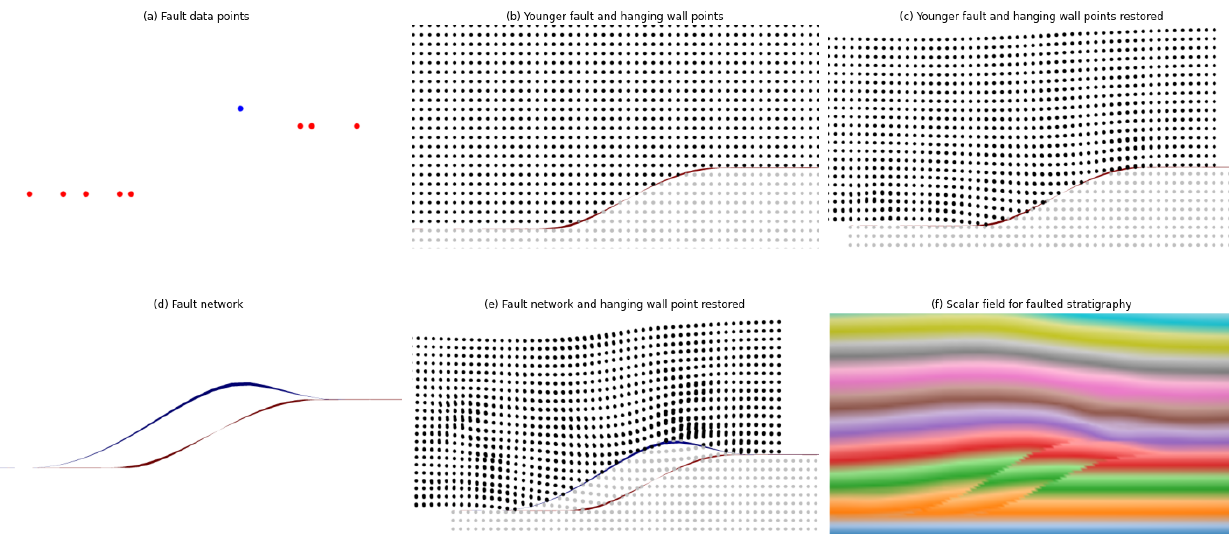
Figure 9. Fault duplex applied to flat-lying stratigraphy. (a) Observations of the fault surfaces with red dots showing the location of both surfaces and the blue dot showing the location of the older fault. (b) Younger fault surface interpolated with model domain showing hanging wall (black) and footwall (opaque) points. (c) Hanging wall points restored by younger fault restoration function. (d) Surfaces for older fault and younger fault. (e) Model restored by both faults with hanging wall of older fault highlighted by black points. (f) Duplex fault network added to scalar field of bedding.